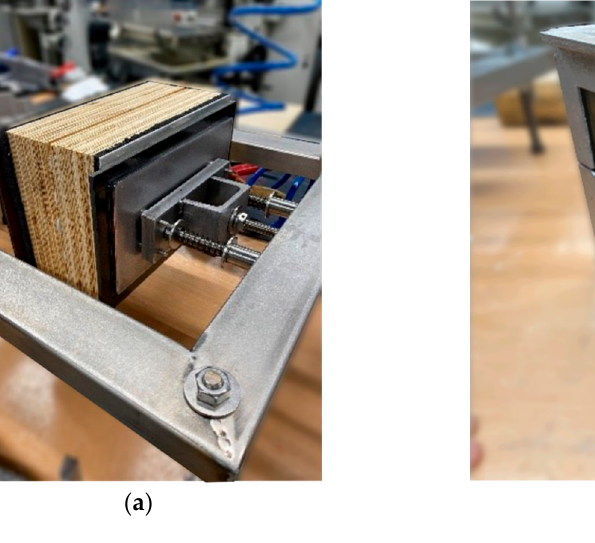
Figure 9. Demonstrator assembly: ( a ) positioning of the cell stack in the joining device; ( b ) assembly of the module shells.